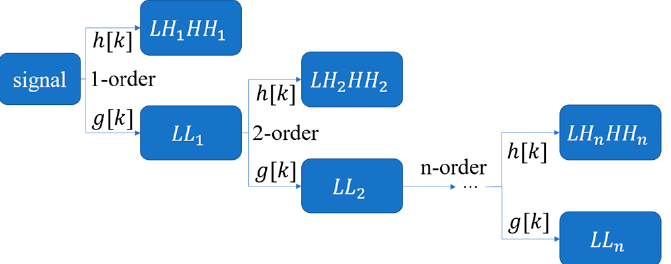
Figure 3. Wavelet decomposition process, where g [ k ] is a low-pass filter, and h [ k ] is a high-pass filter.